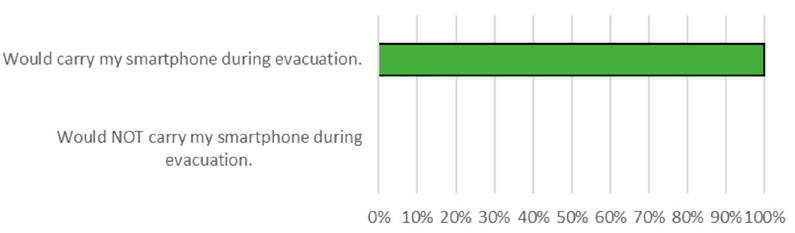
Figure 3. Responses to the question about carrying a smartphone during evacuation.